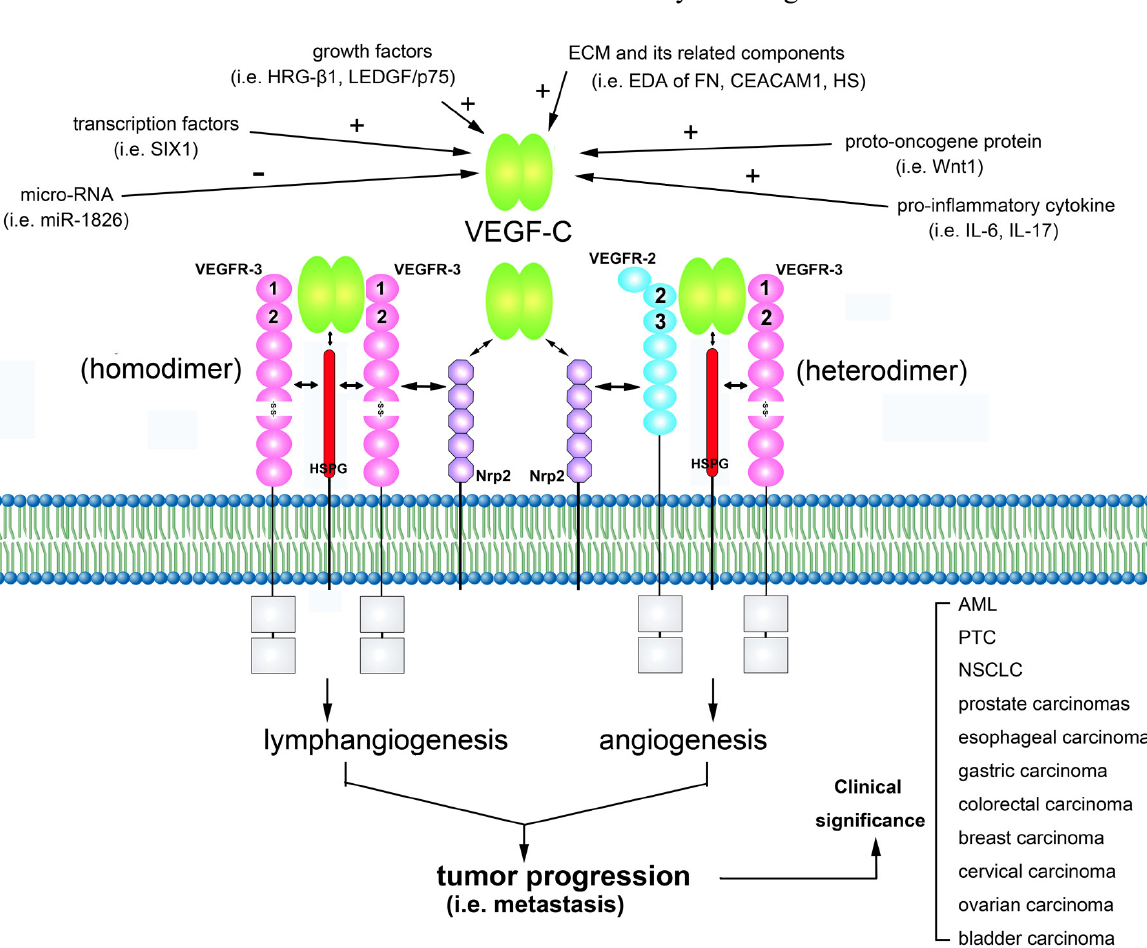
Figure 1. Schematic outline of the interactions of vascular endothelial growth factor C (VEGF-C) with its receptors and co-receptors leading to biological effects in tumor progression. VEGF-C can be proteolytically processed, and the mature form allows binding to VEGF receptor-2 (VEGFR-2) and increased affinity for VEGFR-3. VEGF-C expression is modulated by different manners. Binding of the dimeric VEGF-C stimulates receptor dimerization, leading to the formation of VEGFR-3/VEGFR-3 homodimers and VEGFR-2/VEGFR-3 heterodimers, which is implicated in lymphangiogenesis and angiogenesis, respectively. VEGFR Ig-like domains are involved in VEGF binding as indicated by the loop numbers in the figure. The complex network of intracellular signal transduction pathways results in tumor progression. The clinical significance of the VEGF-C/VEGFRs axes has been described in a variety of